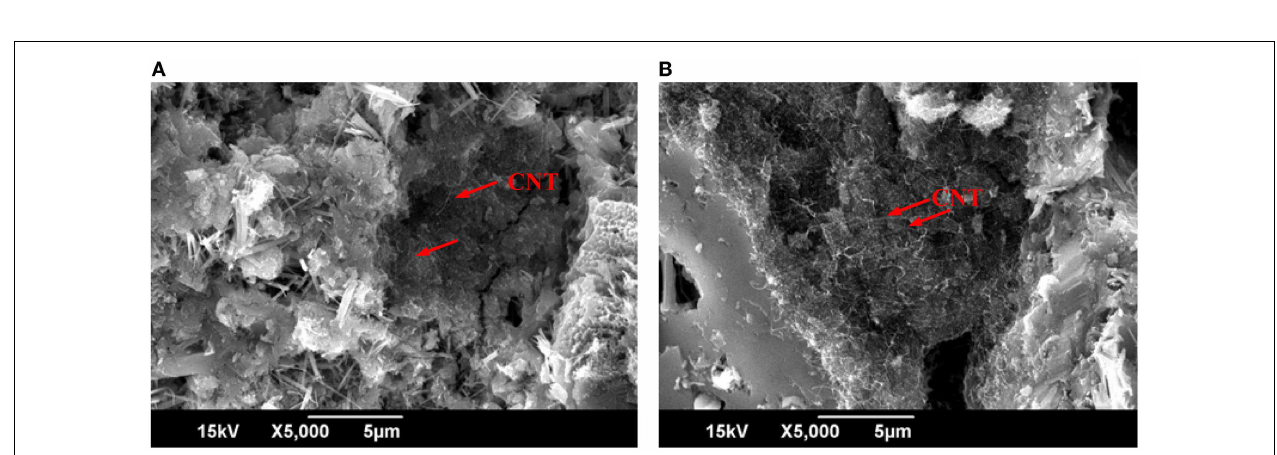
FIGURE 4 | Pressure-sensitivity of CNT filled cement mortar composites with NaDDBS and 0.2 wt.% of MWNT . (A) Under repeated compressive loading with amplitude of 2.5MPa. (B) Under repeated compressive loading with amplitude of 10MPa. (C) Under impulsive loading.